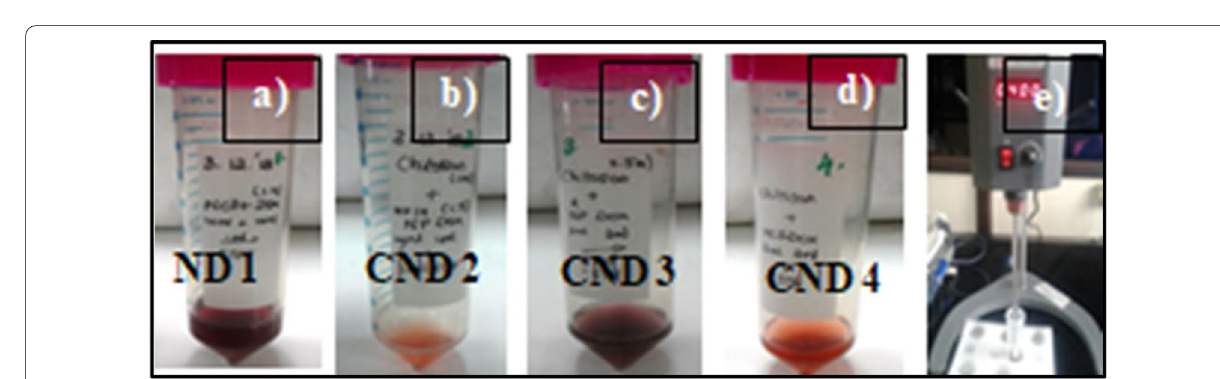
Fig. 7 a – d Synthesized chitosan nanodrug combinations (CND) and e homogenization